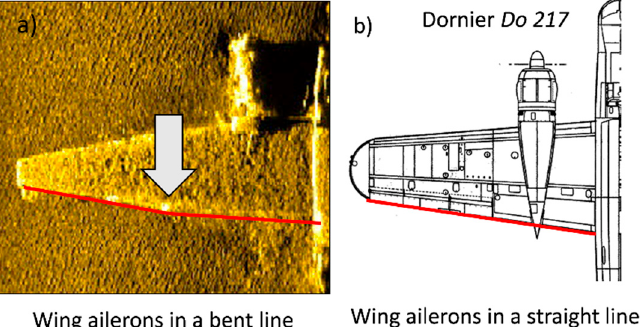
Figure 14. Comparison of the shape and arrangement of the wing ailerons: ( a ) side-scan sonar image of the airplane wreck’s wing, ( b ) plane projection of the Dornier Do 217.